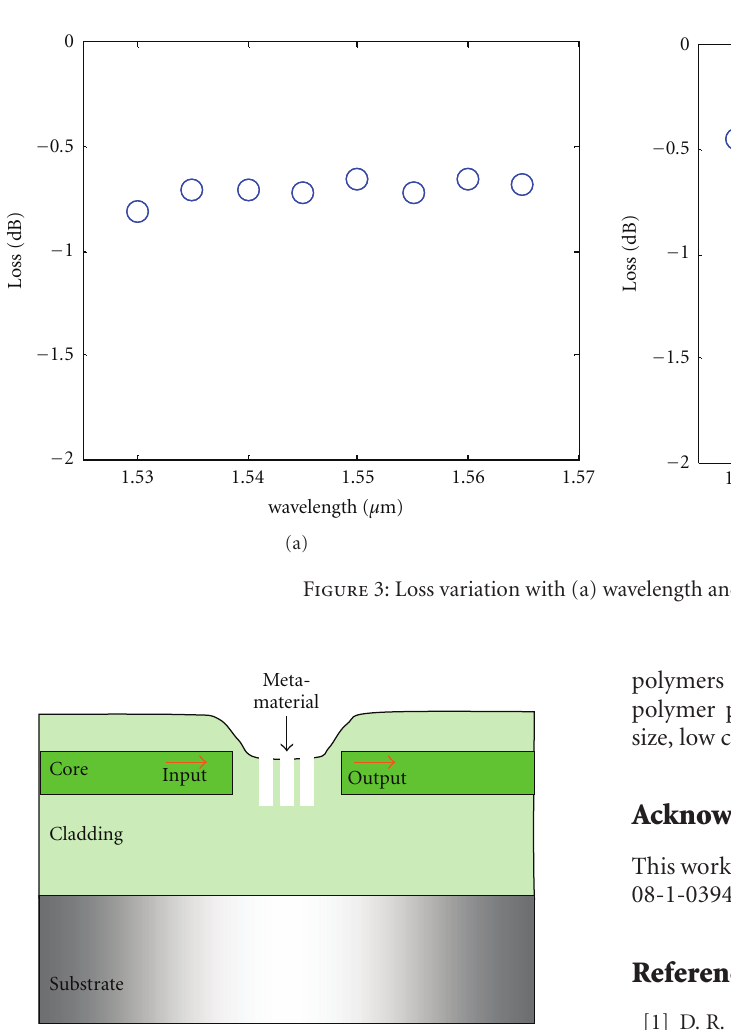
Figure 4: Schematic of an example device structure (side view, not drawn to